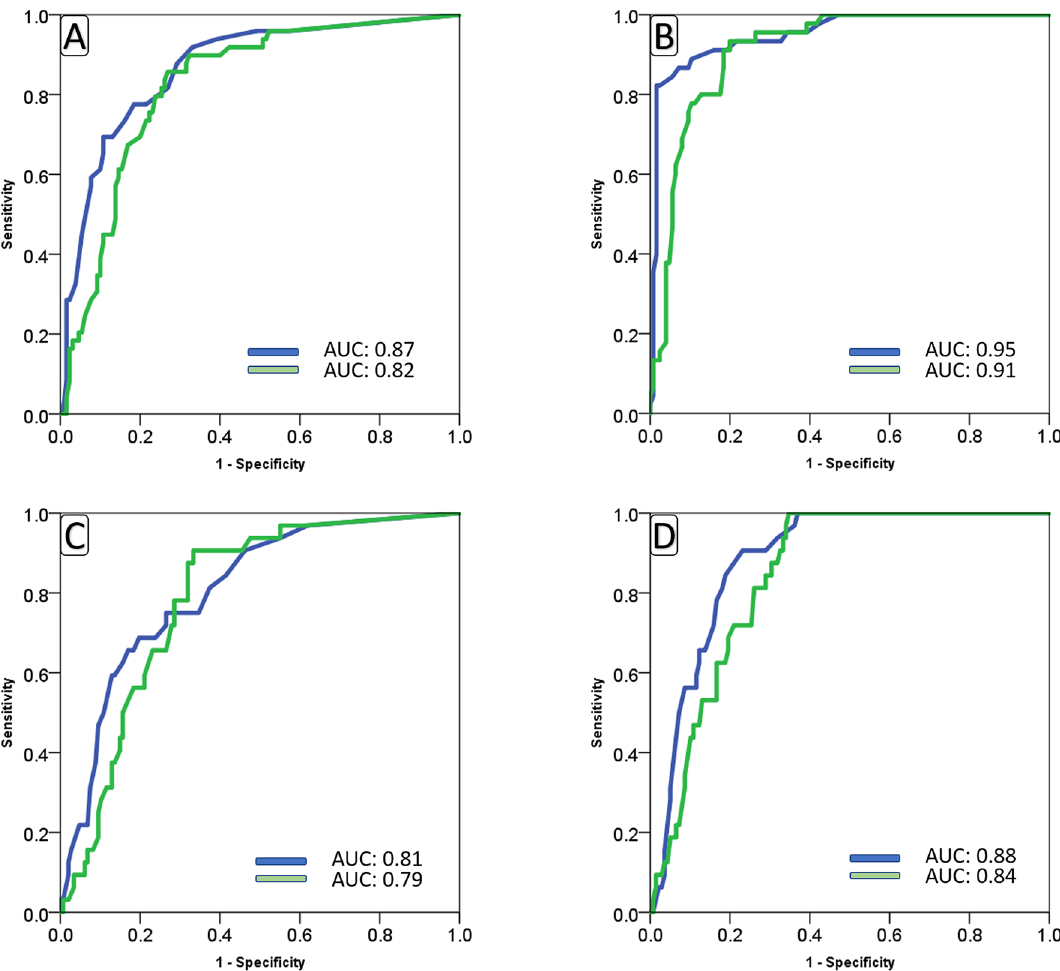
Figure 3. Area under the curve for baseline ( A , C ) and maximum ( B , D ) RALE (blue) and AI (green) scores in Site B patients with different outcomes ( A , B ) of COVID-19 infection and need for mechanical ventilation ( C , D ).